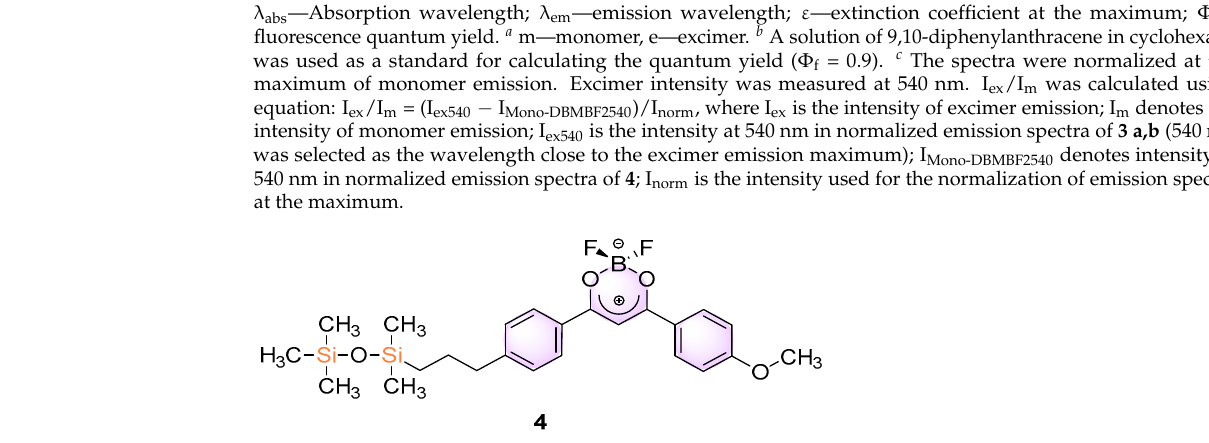
Table 2. Optical properties of polymers 3 a,b and model compound 4 . Figure 19. Frequency dependences of G ′ , and G ″ for polymers 3 a ( top ) at 160 °C and after cooling to 20 °C, and for polymer 3 b ( bottom ) at 160 °C and after heating at 160 °C for 1h.